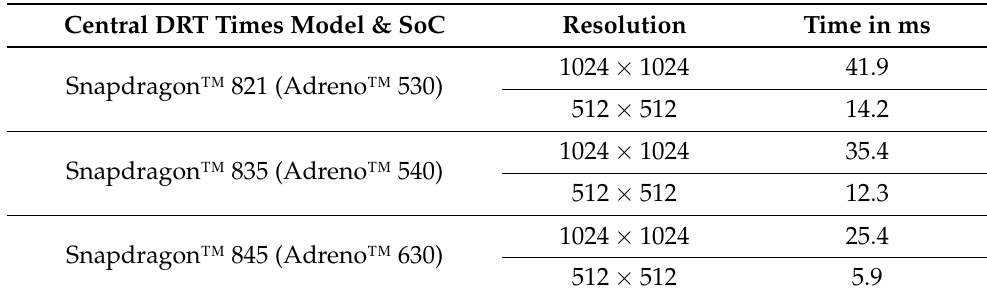
Figure 20. The position on Radon space of the most prominent edges are highlighted. With this information, the rectangle is determined in image coordinates; simultaneously, the output of DRT is being shown, in order to verify the ability to compute the DRT on an smart-phone camera preview pipeline. Table 1. Measured times, in milliseconds, of an Android™ application, running a GPU implementa- tion of the central DRT on different SoCs with different resolutions.